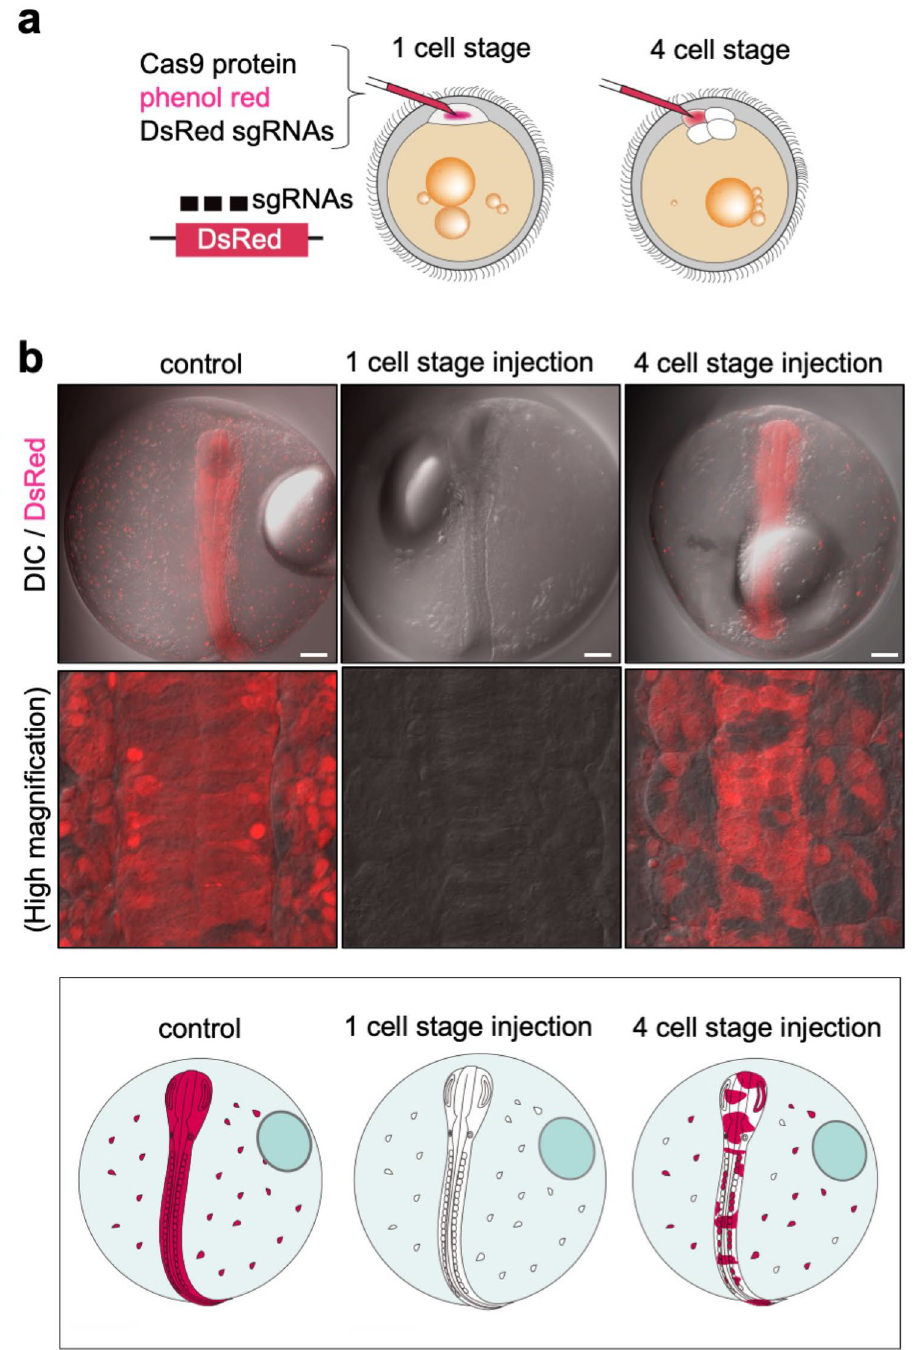
Figure 3. Efficient generation of genetic mosaics in N. furzeri embryos. ( a ) Schematic representation of a method for generating whole body and mosaic knockouts. SgRNAs for the DsRed gene, Cas9 protein, and phenol red are co-injected into one-cell-stage or 4-cell-stage embryos. ( b ) DsRed distribution in 7 dpf embryos uninjected (control) or injected with DsRed sgRNAs at 1-cell or 4-cell-stage. The top and middle panels show the whole embryo image and a high magnification image of the trunk region, respectively. Scale bar: 100 μm. The bottom panel shows an illustration of DsRed distribution in the